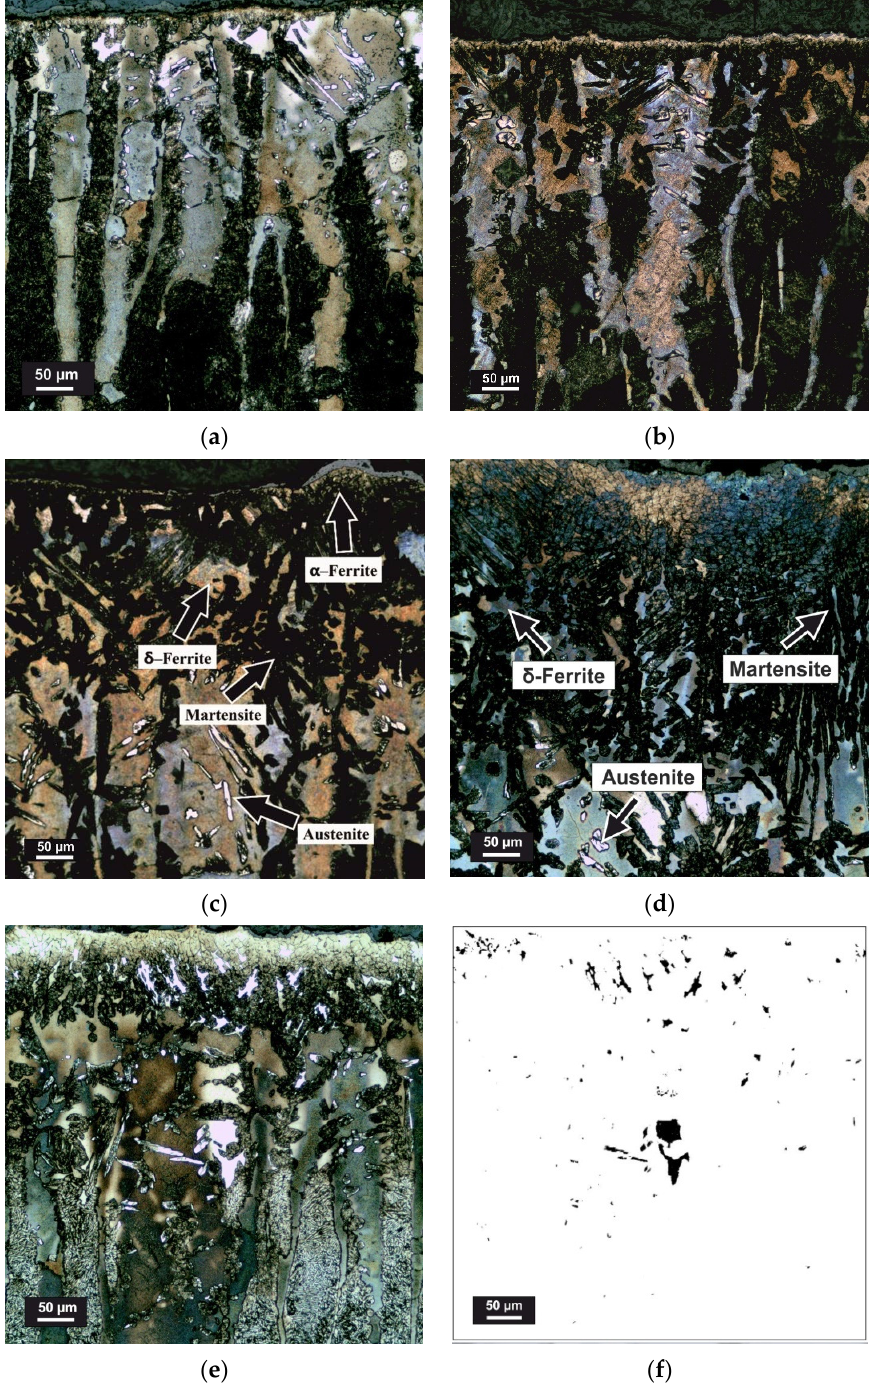
Figure 7. Microstructure of the hardened area, ( a ) No.4; ( b ) No.5; ( c ) No.6; ( d ) No.14; ( e ) No.12; ( f ) automatic identification of austenite. ( f ) automatic identification of